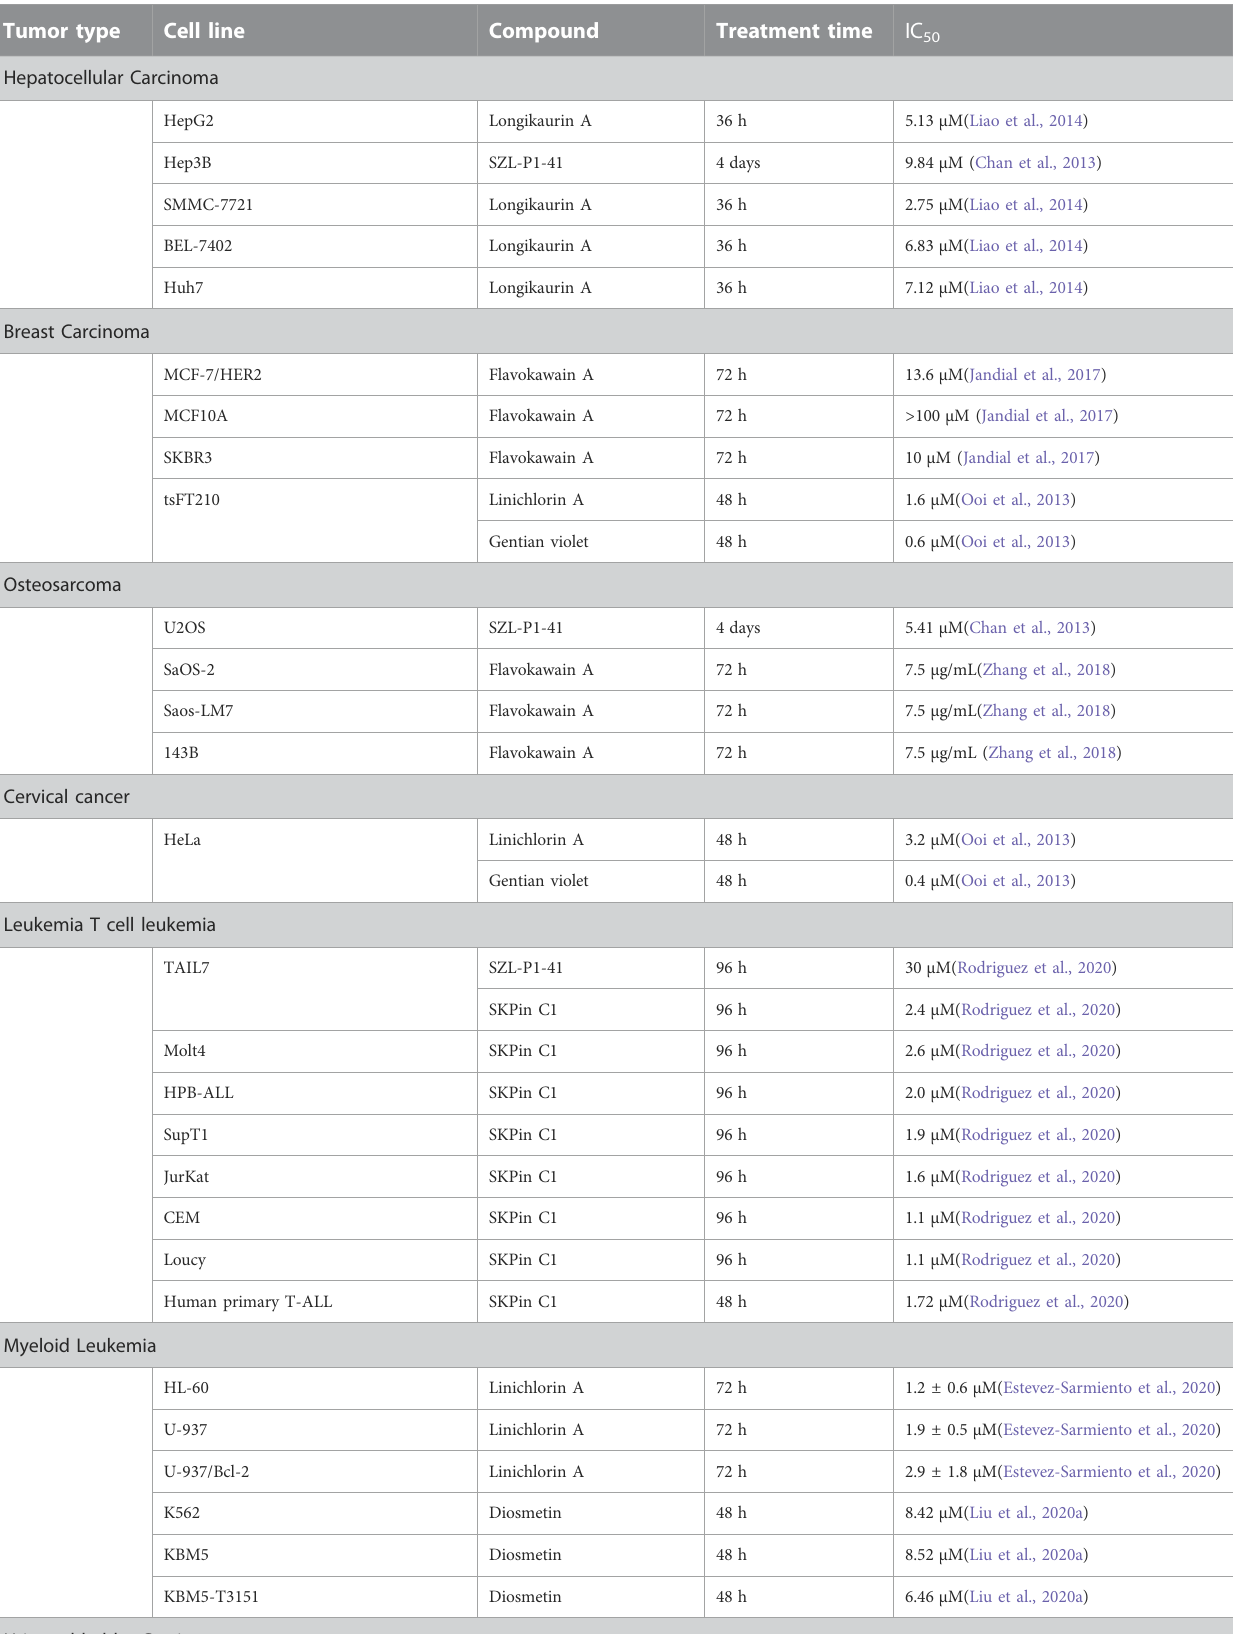
TABLE 2 ( Continued ) Inhibitory effects of the Skp2 inhibitors or inhibiting compounds in various kinds of tumors at cellular level. Tumor